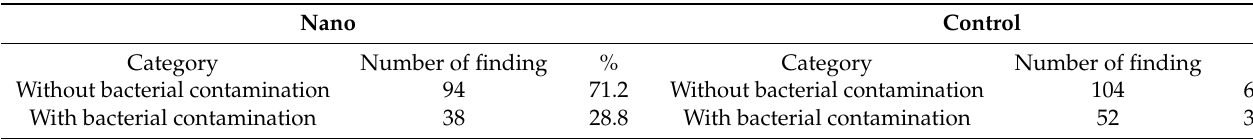
Table 1. Culture results in emesis basins.